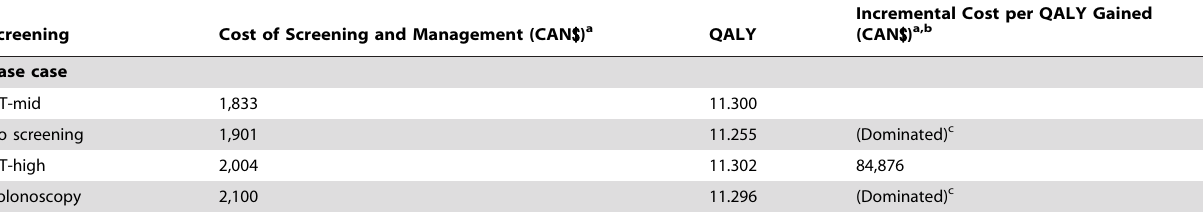
Table 6. Sensitivity